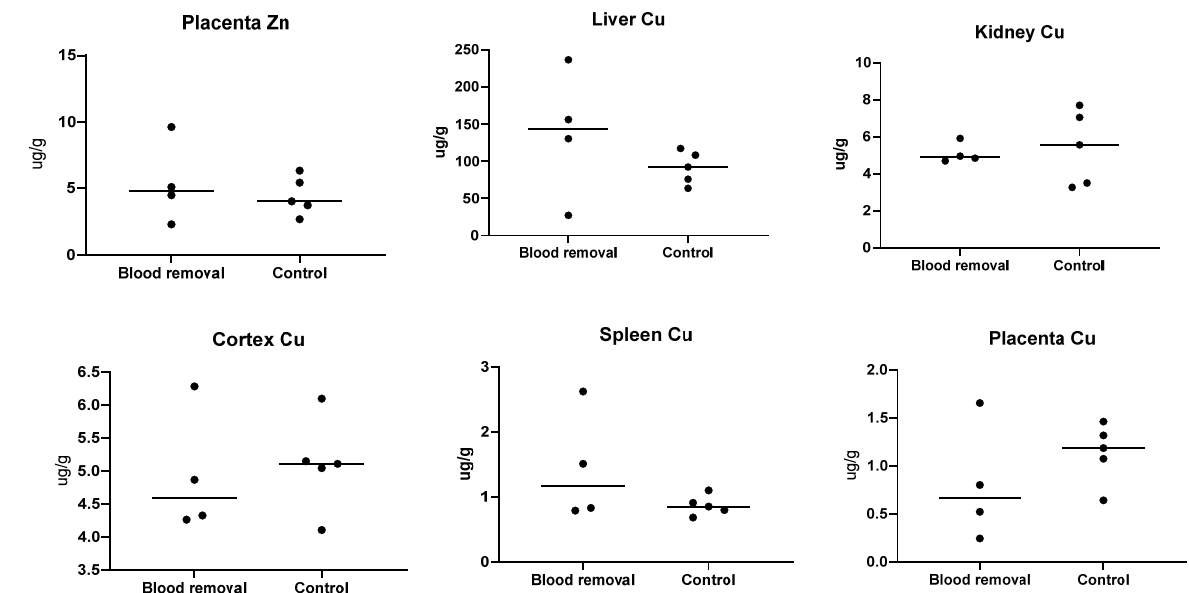
Figure 6. Tissue concentrations of iron (Fe), zinc (Zn) and copper (Cu) in sows from trial II. * indicates a significant difference between groups (** p < 0.01 and * p < 0.05). Sows from the blood removal group had been subjected to blood removal procedures from early gestation and received an iron-reduced diet.